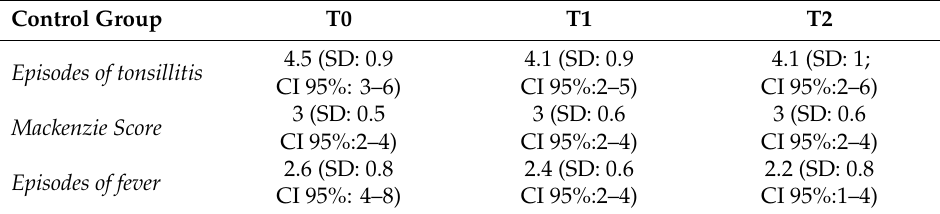
Table 3. Average of clinical data in group B observed at the three di ff erent follow-up visits. Control Group T0 T1 T2 Episodes of